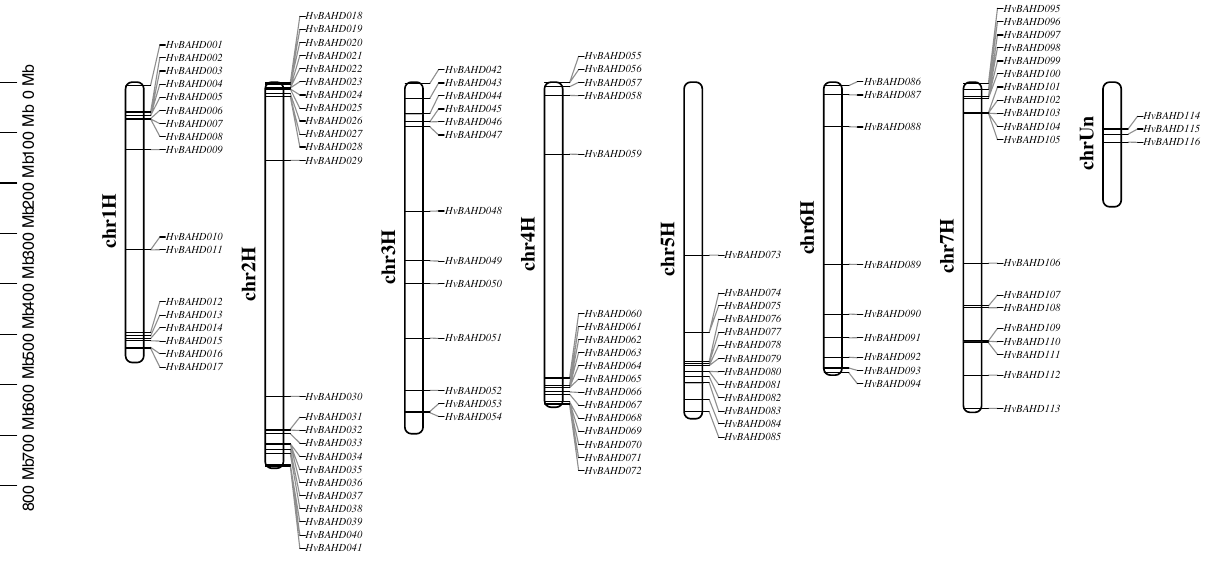
Figure 3. Distribution of 113 putative HvBAHD genes (3 genes on unknown chromosome; chrUn) across the seven chromosome (chr) groups of barley. All barley chromosomes are drawn to scale based on predicted lengths. This picture was constructed by TBtools v1.082 (https:// doi. org/ 10. 1016/j. molp. 2020. 06.